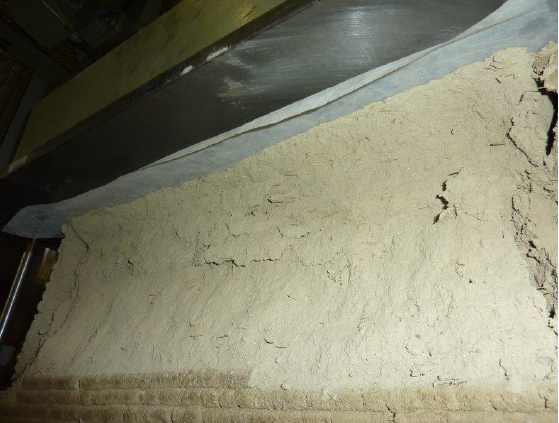
Figure 27. Appearance of the extruded layers along one of the sliding surfaces activated by crack propagation.